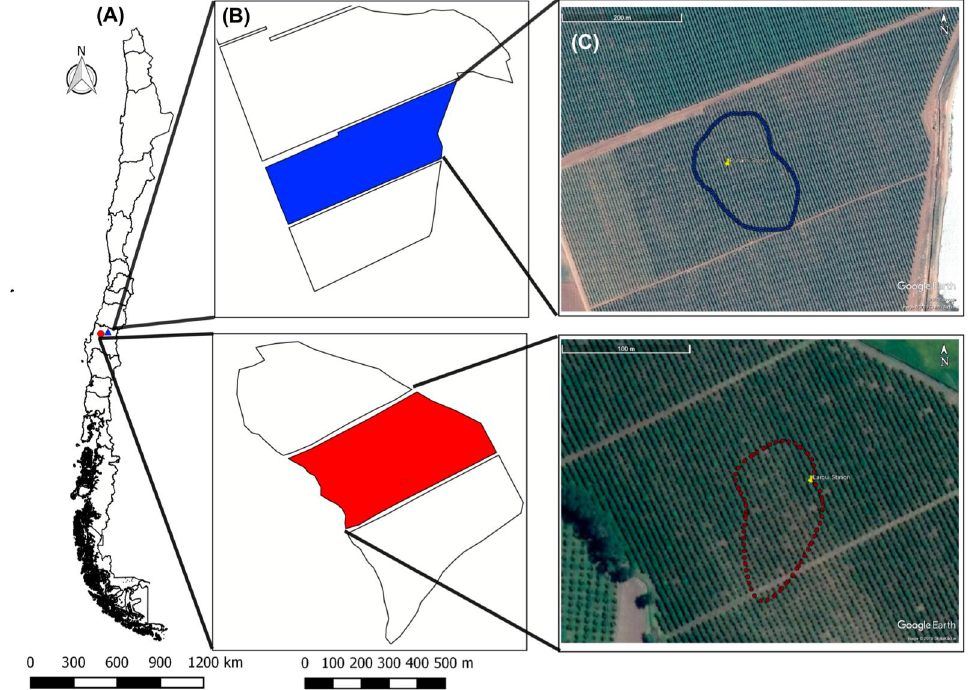
Figure 1. Locations of the study sites ( A , B ), S1 (top right) and S2 (bottom right), in the Diguillin Province, Ñuble Region of Chile ( A ). Footprint area ( C ).